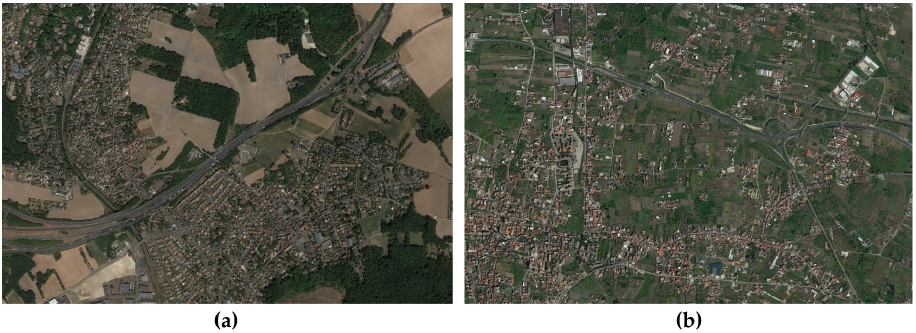
Figure 1. Example of sprawl in Paris ( a ) and sprinkling in Naples ( b